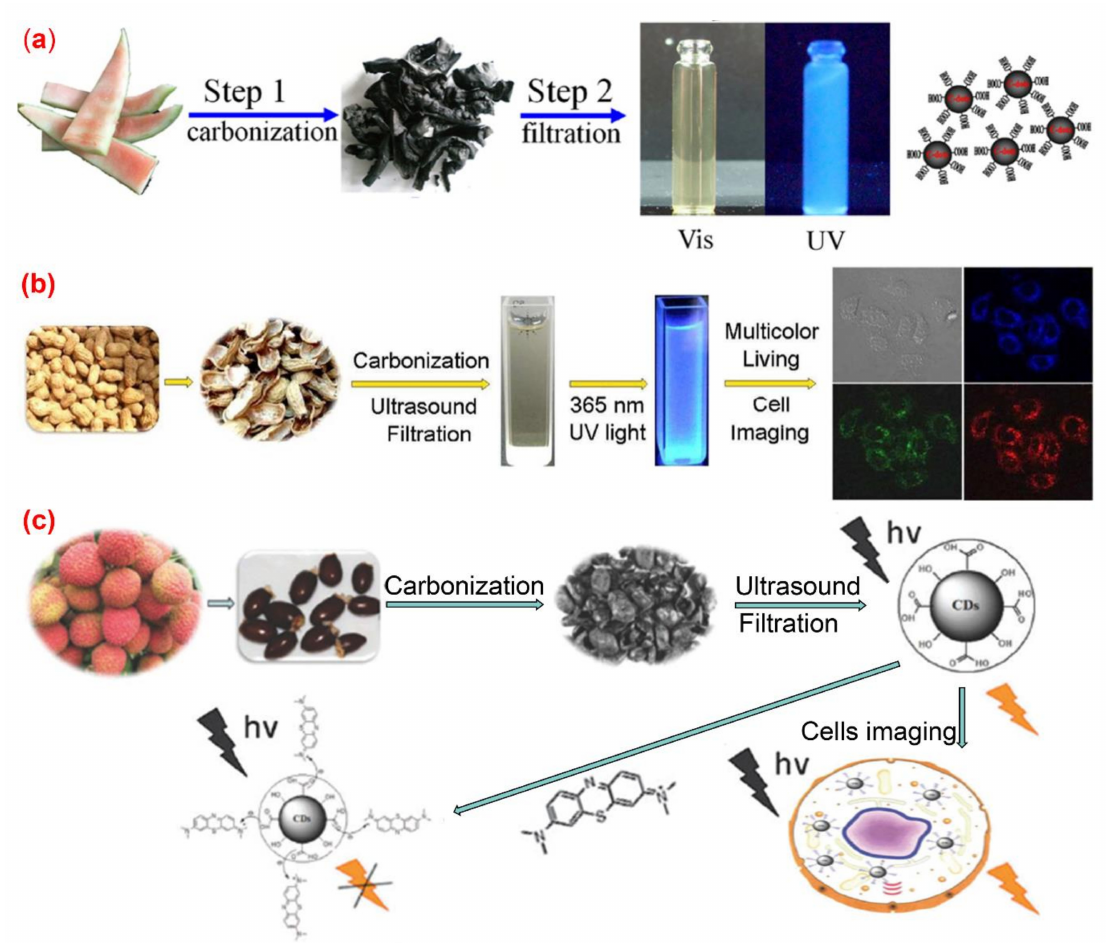
Figure 3. Preparation of fluorescence C-dots from agriculture wastes by pyrolysis method. ( a ) Synthesis of water-soluble C-dots from watermelon peel [52]; ( b ) the preparation and application of fluorescent C-dots from lychee seeds [53]; ( c ) the preparation and application of C-dots from peanut shells